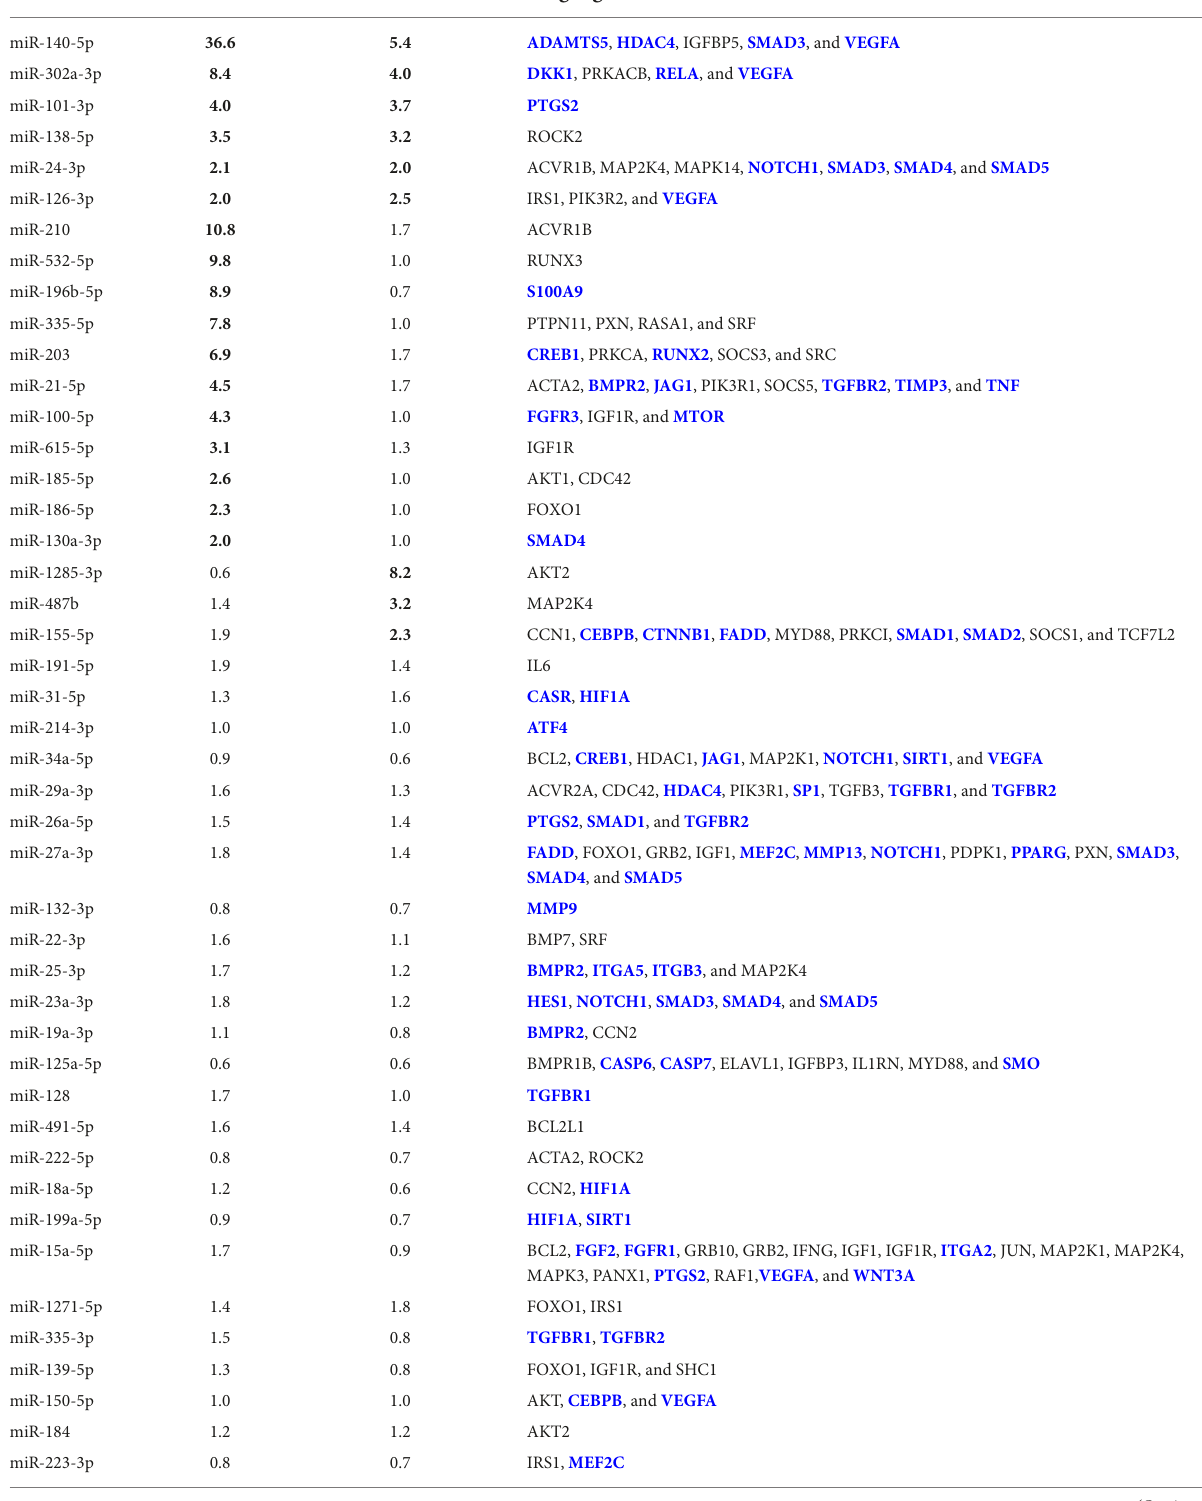
TABLE 1 micro RNAs (miRNAs) in the extracellular vesicle (EVs) from cartilage cells (CCs), adipose tissue-derived (ASCs), and bone marrow-derived stem cells (BMSCs) and their target genes identified as involved in inflammation or osteoarthritis (OA) (target genes in blue) by ingenuity pathway analysis